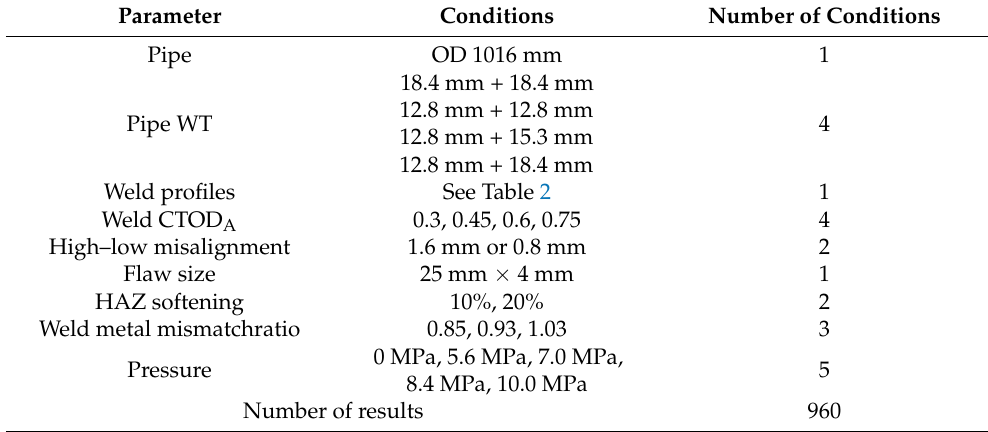
Table 5. Summary of conditions analyzed.